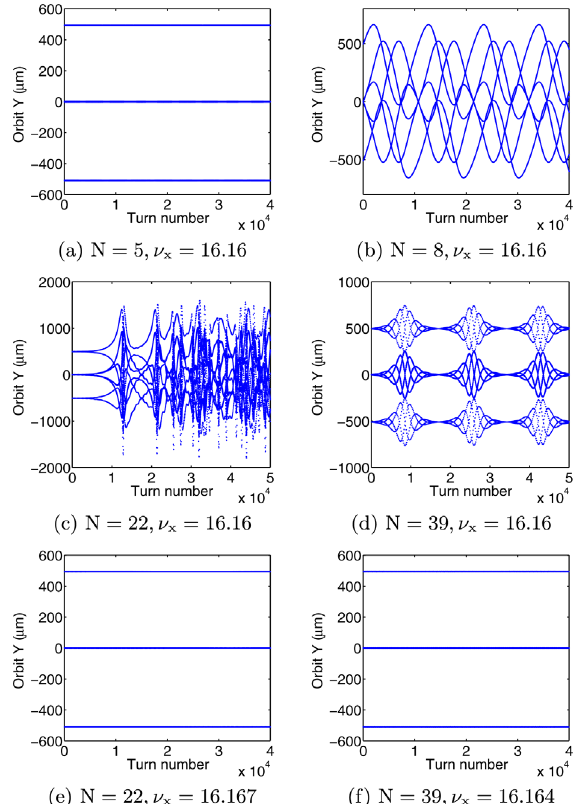
FIG. 5. Simulated turn-by-turn beam orbits at beamline 3.1 for different KAC period N ¼ 5 , 8, 22, 39. (a) Stable KAC beam orbit at N ¼ 5 ; (b) Unstable beam orbit at the resonance of the integer multiple of 4, N ¼ 8 ; (c) and (d) Unstable beam orbits at the coupling resonances N ¼ 22 and N ¼ 39 , respectively; (e) and (f) Stabilized beam orbits after adjusting the horizontal tune away from the coupling resonances at N ¼ 22 and N ¼ 39 ,